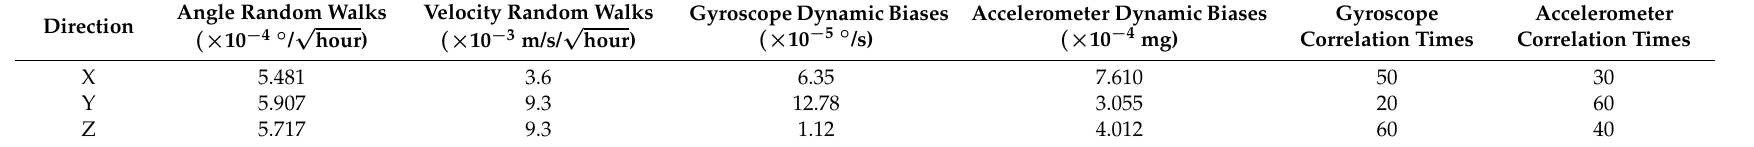
Table 1. The error parameters of the IMU determined by the Allan variance